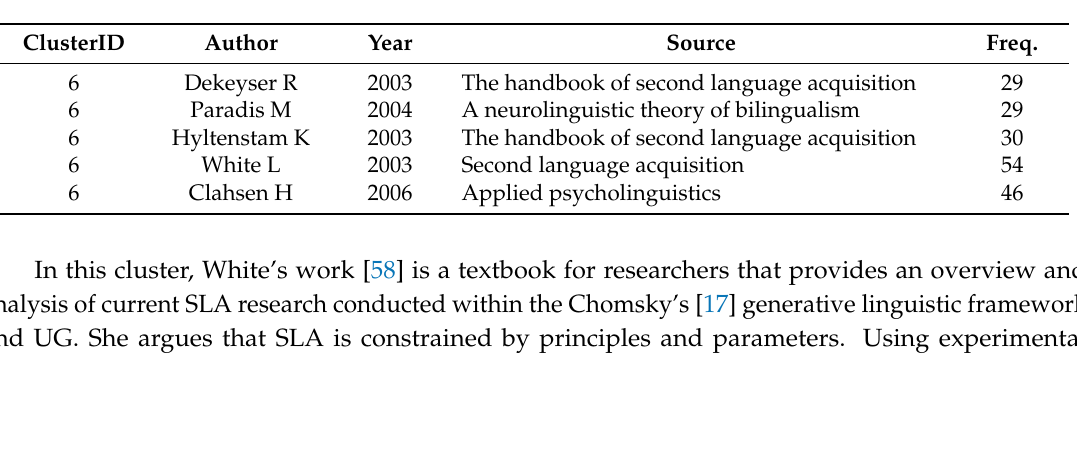
Table 8. The Members of Cluster